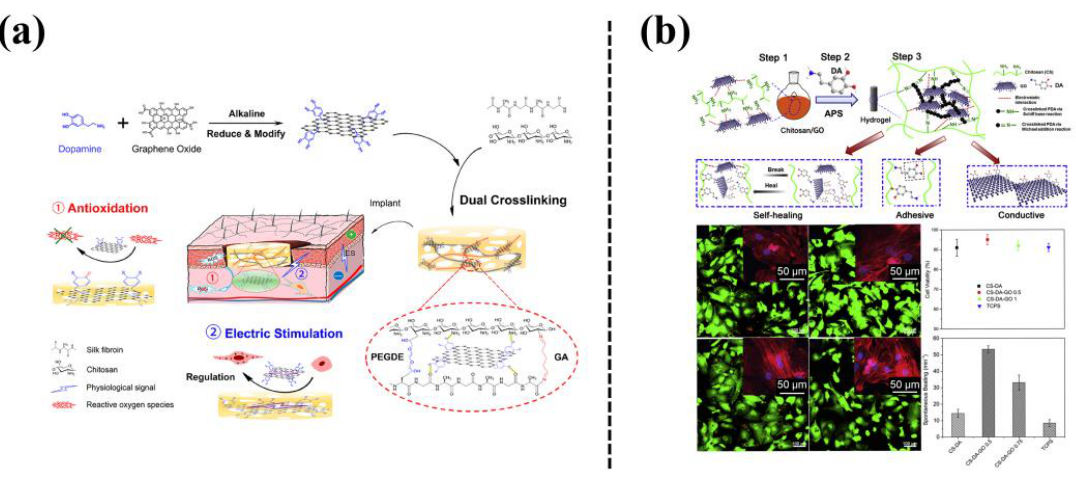
Figure 16. ( a ) Preparation of a dual-crosslinked pGO-CS/SF scaffold for repairing skin wound defects [109]. ( b ) Schematic of preparation of a CS-DA-GO composite hydrogel. Primary cardiomyocytes derived from human embryonic stem cells were seeded onto CS-DA-GO composite hydrogels to evaluate the biocompatibility of the hydrogels for cardiac tissue engineering [110].